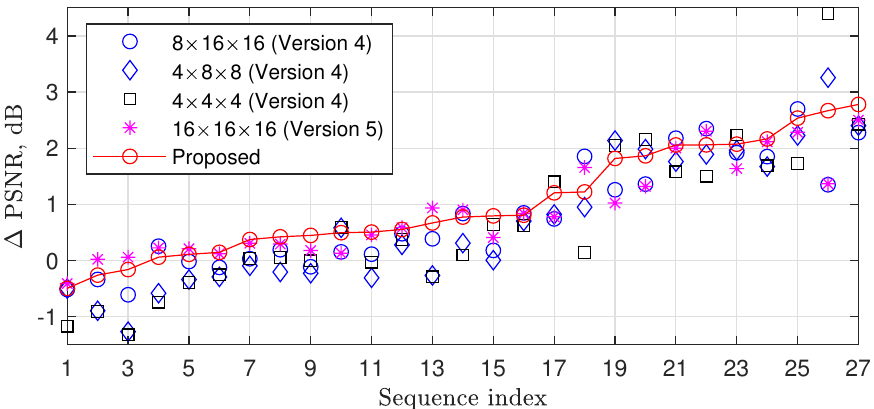
Figure 5. PSNR improvements related to [21] for the thresholding with 3D DCT block sizes 8 × 16 × 16, 4 × 8 × 8, 4 × 4 × 4 and 16 × 16 × 16 and the proposed thresholding in which the block size is selected from a set { 8 × 16 × 16,4 × 8 × 8,4 × 4 × 4, and 16 × 16 × 16 } at each iteration with a probability of